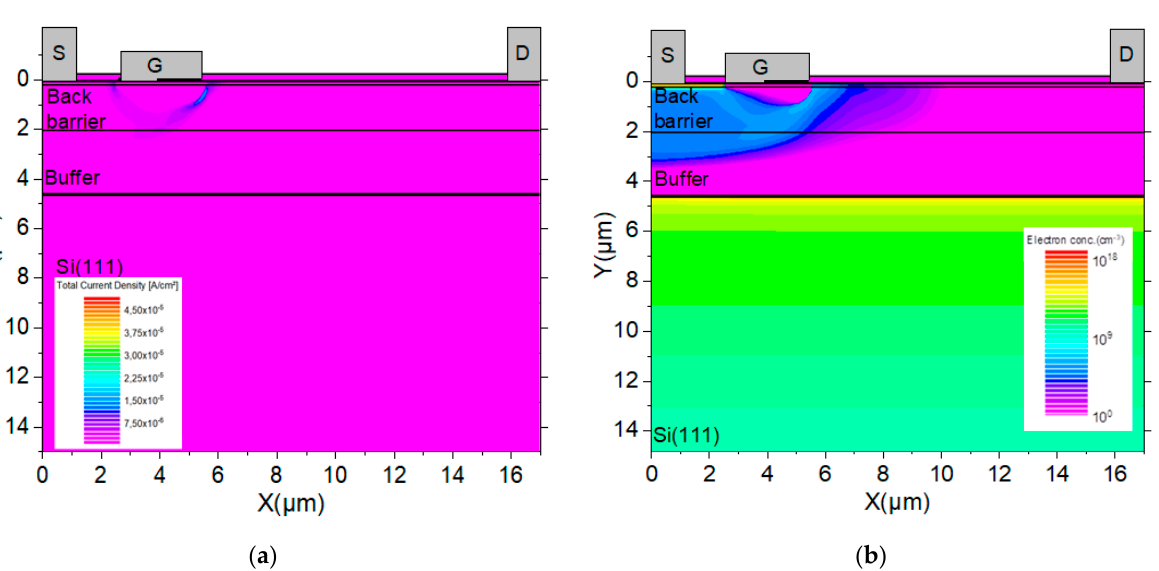
Figure 8. MOS-HEMT structure cross section of ( a ) current density and ( b ) electrons concentration at 500 V showing no current path through the 2DEG at AlN/Si interface. A small leakage current 10 − 14 A/mm through the buffer is denoted.